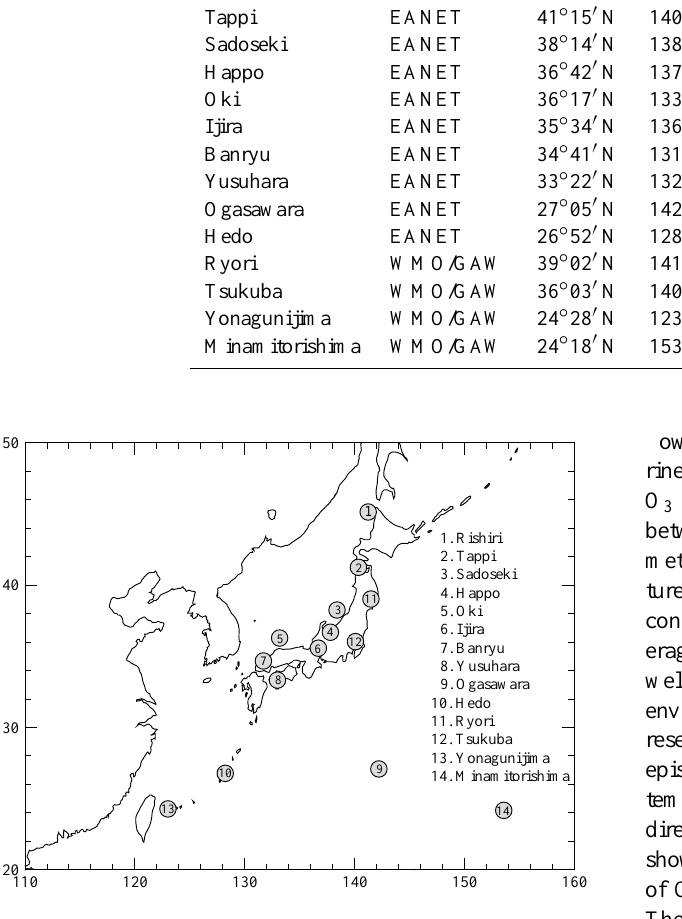
Fig. 1. Locations of EANET and WMO/GAW stations used in evaluating model performance.